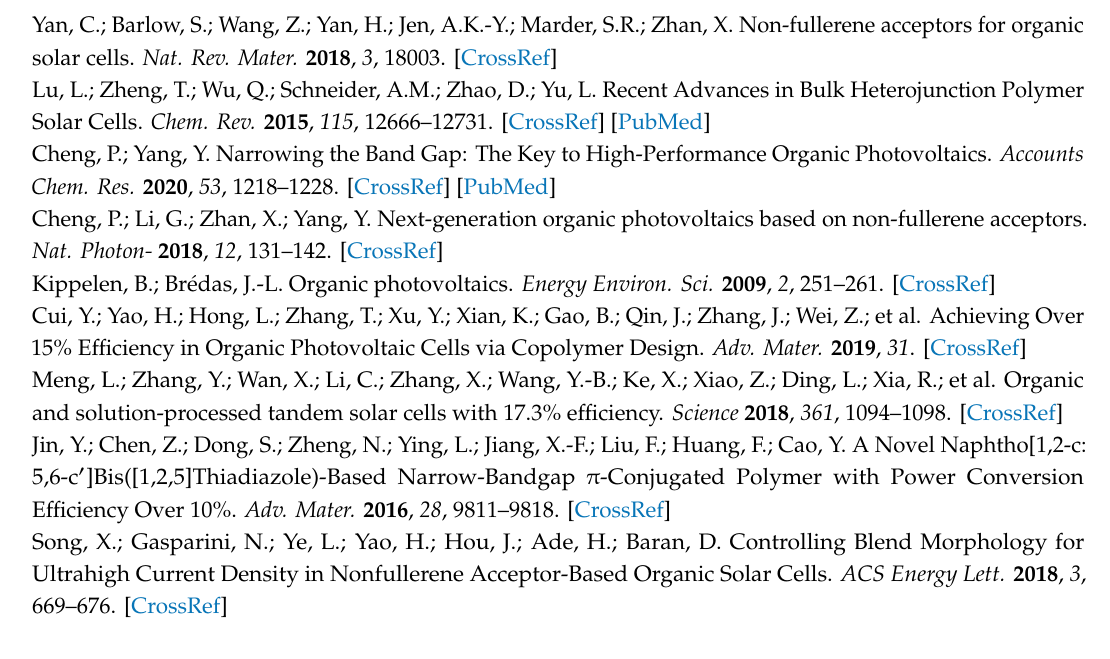
polymers, Figure S4: Optimized molecular models for ( a ) PT-ODTTBT and ( b ) PTT-ODTTBT . Energy levels and distribution of the corresponding ( c , d ) LUMO and ( e , f ) HOMO, Figure S5: Cyclic voltammograms of synthesized polymers, Figure S6: J–V characteristics and EQE curves of the OPV devices based on PT-ODTTBT :PC 71 BM with various blending ratios (up) and DIO volumes (down), Figure S7: J–V characteristics and EQE curves of the OPV devices based on PTT-ODTTBT :PC 71 BM with various blending ratios (up) and DIO volumes (down), Table S1: Performance of the OPV devices based on PT-ODTTBT :PC 71 BM, Table S2: Performance of the OPV devices based on PTT-ODTTBT :PC 71 BM, Table S3: Azimuthal angle scan profiles for the synthesized polymer films at the (100)